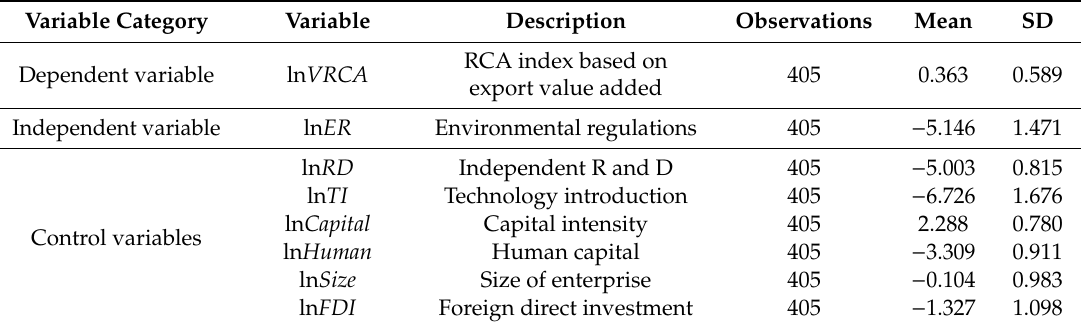
Table 1. Statistical descriptions of the main